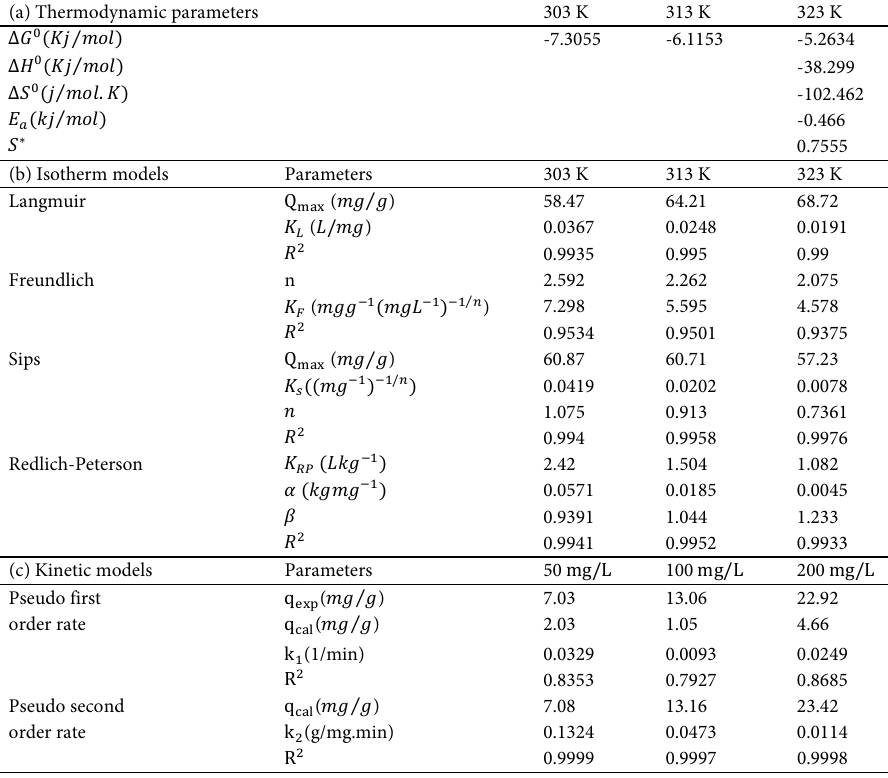
Table 2. a) Thermodynamic parameters, b) Isotherm parameters, and c) Kinetic parameters